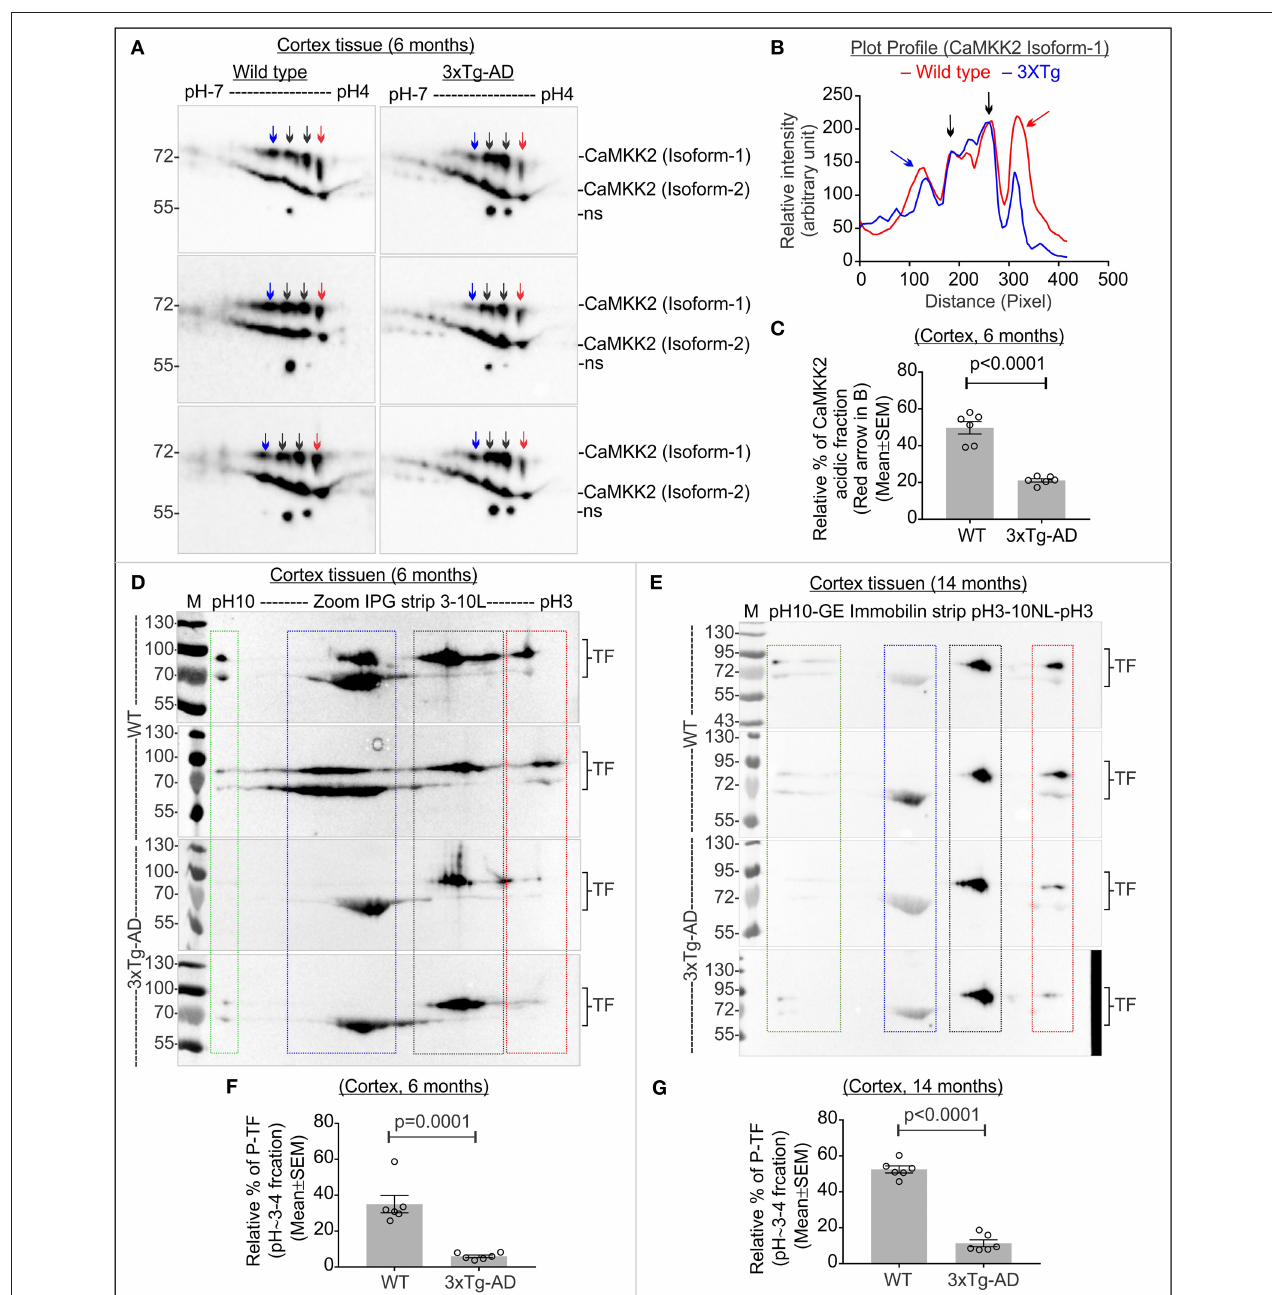
FIGURE 7 | Altered CaMKK2 and reduced P-TF in 3xTg-AD mice. (A) Immunoblot showing charged fractions of CaMKK2 isoform 1 and 2 in 6 months’ old wild-type and 3xTg-AD mice. Colored arrows indicate different charged fractions. Linear pH 4-7 IPG strips were used to resolve closely spaced CaMKK2 charged fractions. (B) Plot profile showing relative intensity of the focused CaMKK2 isoform-1 spots. (C) Scatter plot showing relative percentage of the comparatively more negative charged fraction (red arrow) of CaMKK2 isoform-1. The spots marked with black arrows were used for normalization because their intensity was not altered in different categories. (D,E) Immunoblots showing charged fractions of TF in 6 and 14 months old 3xTg-AD mice cortex tissues. The colored rectangle indicates different charged fractions. (F,G) Scatter plot showing relative intensities of the P-TF (red rectangle). The intensities of pH ∼ 5-6 fractions were used for normalization. N = 6 replicates from 3 mice in each category. The p -value by t -test